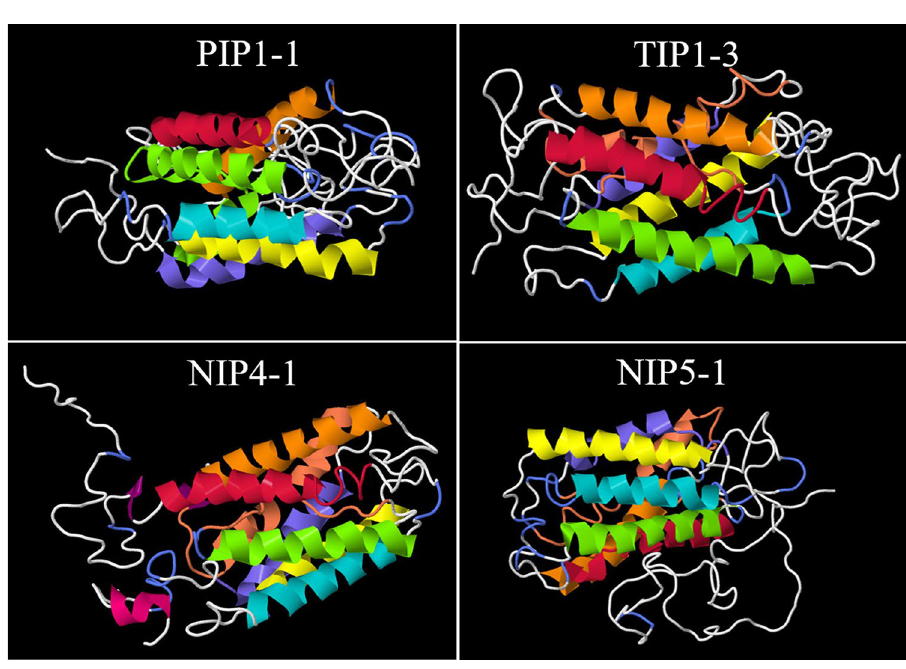
Figure 3. 3D protein structure prediction for C. melo aquaporins: CmPIP1.1, CmTIP1.3, CmNIP4.1 and CmNIP5.1. Identification of the six transmembrane helices (H1–H6) and the additional two re-entrant helices are highlighted with different colours (H1 fuchsia, H2 green, H3 orange, H4 yellow, H5 sky blue, H6 dark blue, Re-entrant helices salmon). Protein structures were performed using Jmol